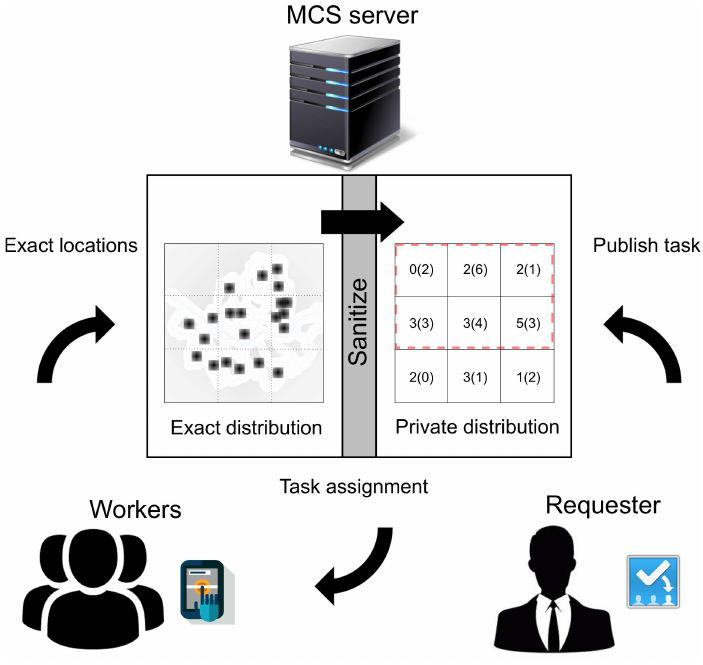
Figure 1. A framework for mobile crowdsensing using PSD. MCS, Mobile